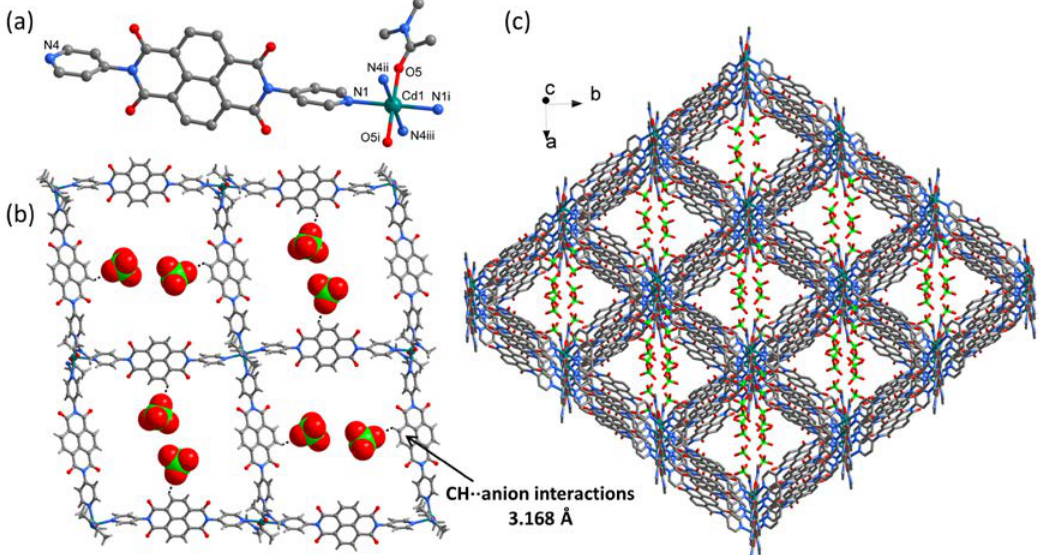
Figure 3. ( a ) The coordination environment of the Cd atom in 3 , symmetry codes: (i) 1 – x, –y, 2 – z; (ii) 0.5 + x, 0.5 – y, –0.5 + z; (iii) 0.5 – x, –0.5 + y, 2.5 – z; ( b ) the square-grid framework, in which ClO 4–